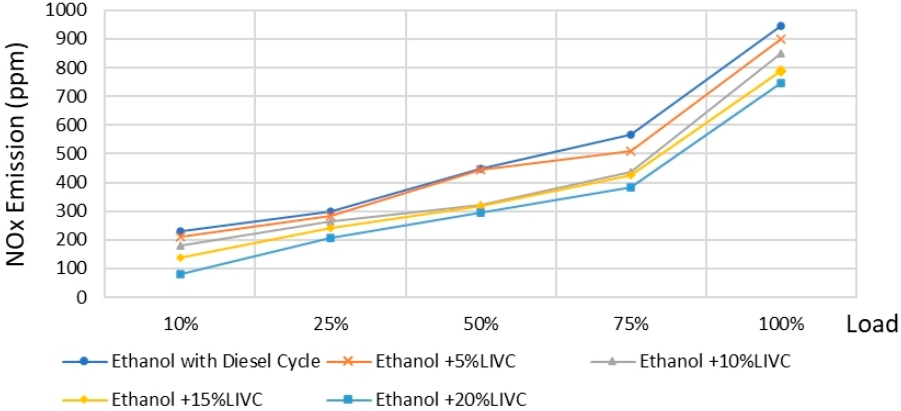
Figure 21. BTEE(%) of ethanol engine with LIVC Miller Cycle.